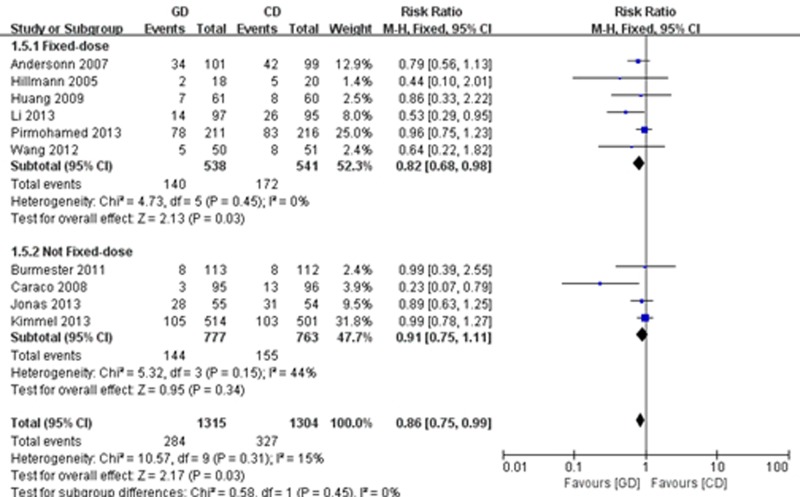
Forest plot of adverse events.